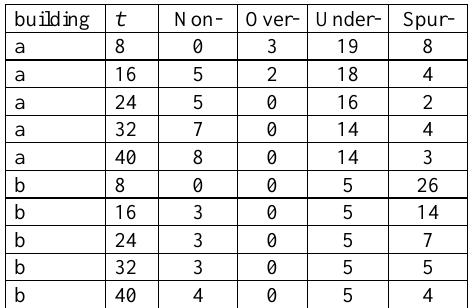
Table 1. Numbers of detected planes. (a) Building with complex shapes in Figure 9(a). (b) high-rising residential building in Figure